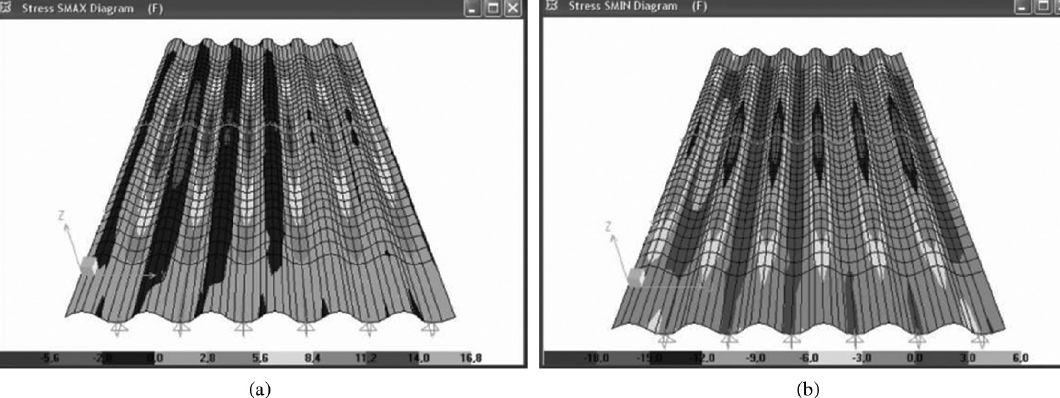
) in the lower surface of the low wave, max